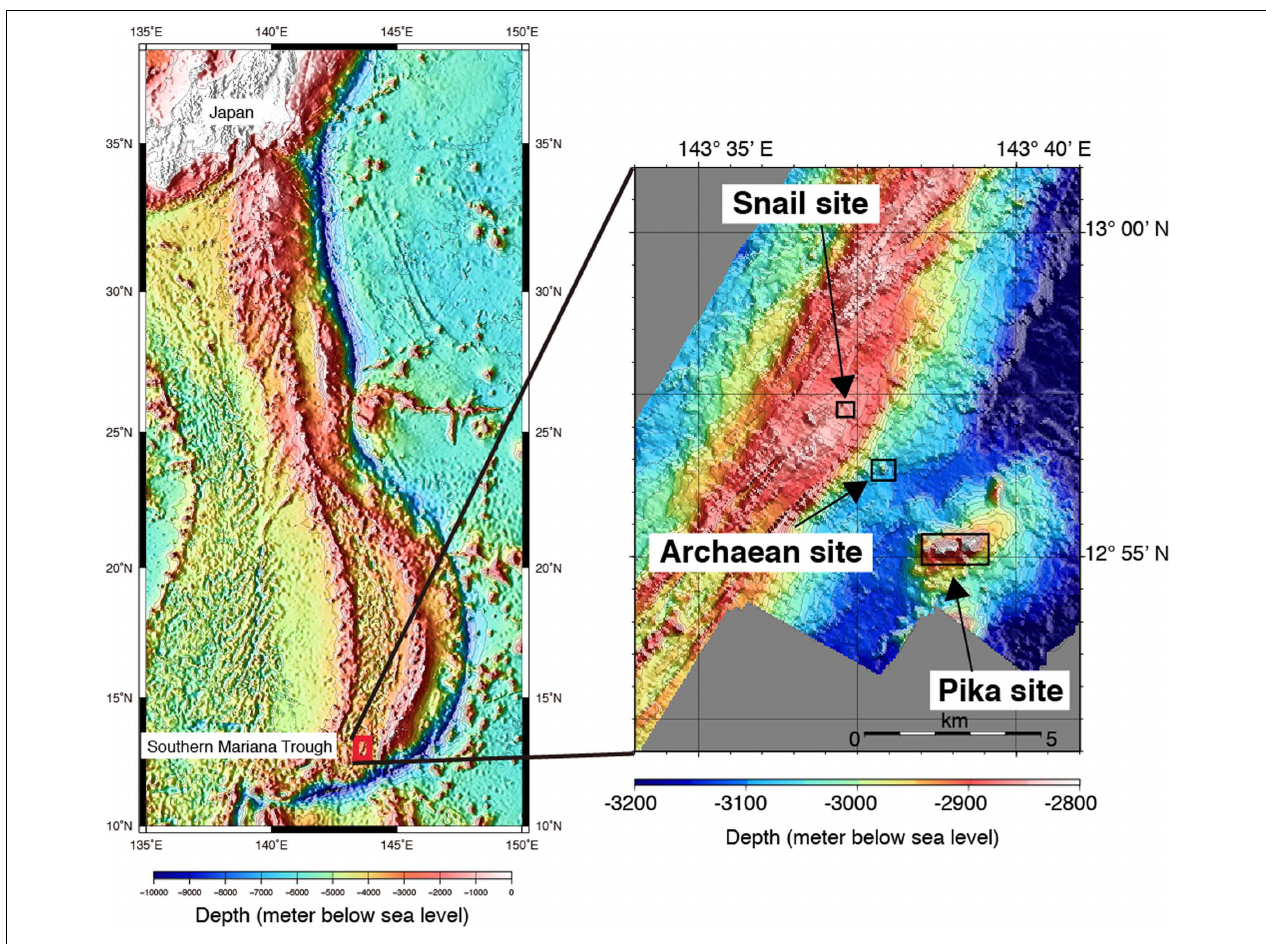
FIGUREA1 | (A) Topographic map of the Southern MarianaTrough with (B) an enlarged view of the hydrothermal areas.